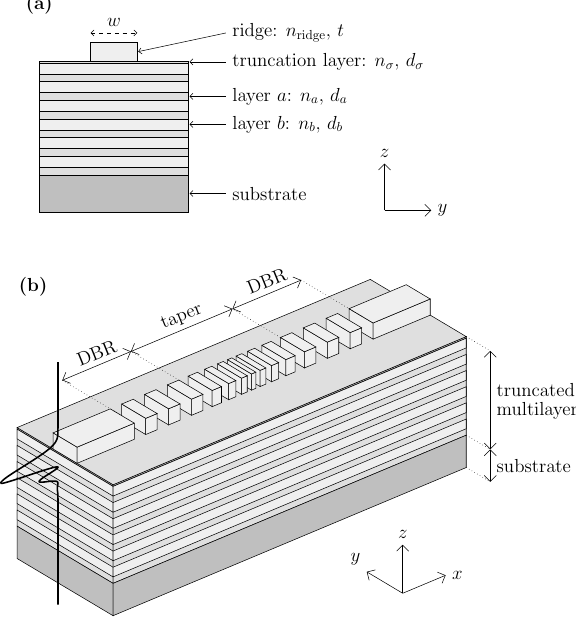
Figure 1. (a) Cross section of the PhC ridge. (b) Sketch of the BSW-based